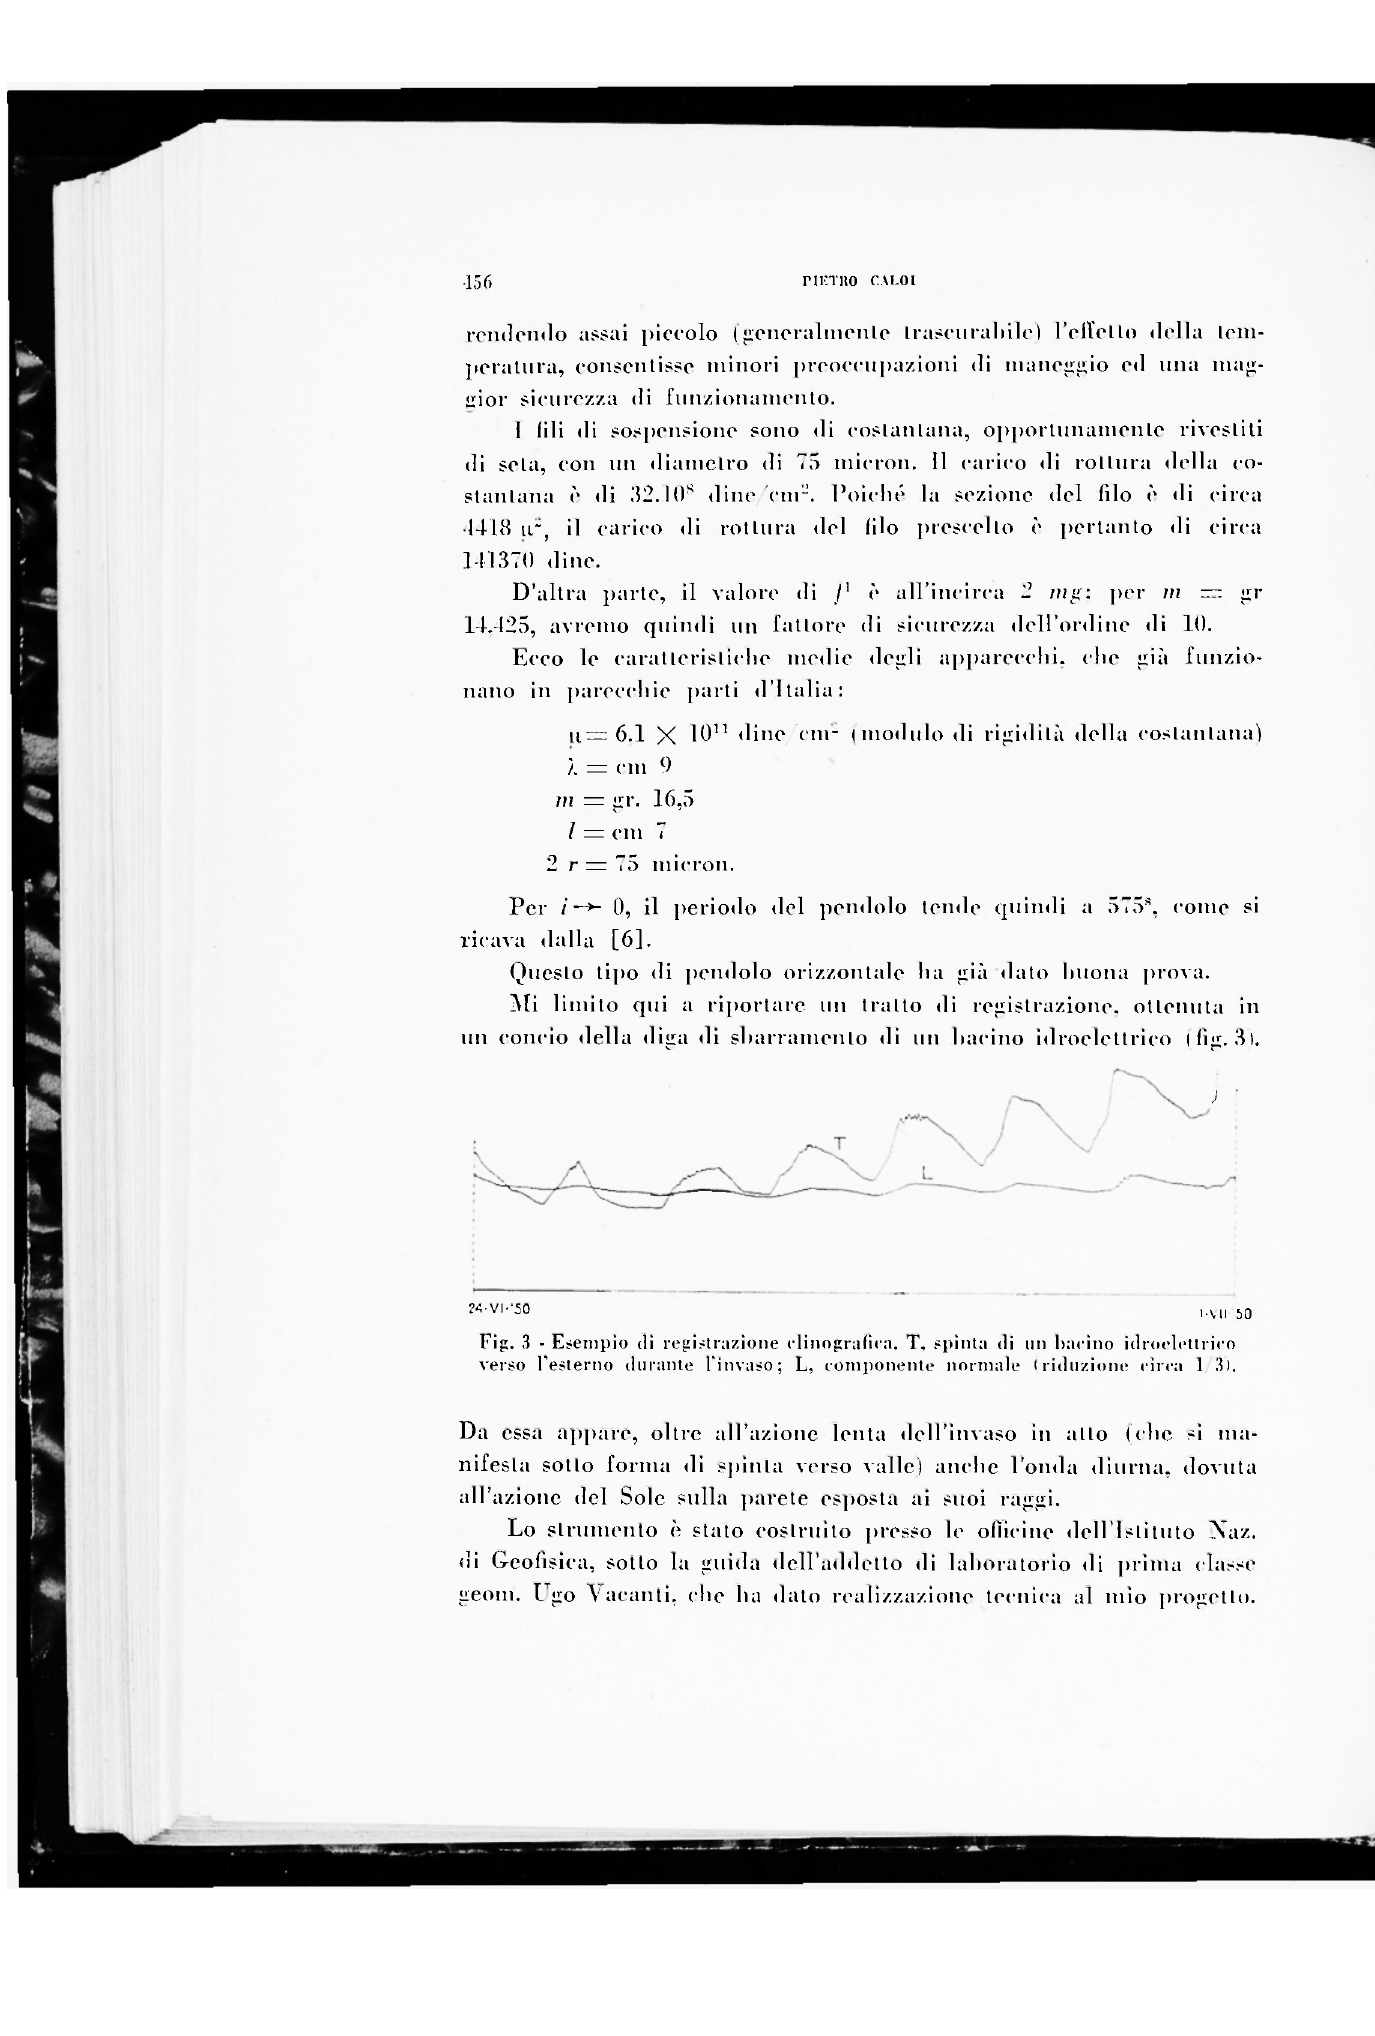
Da essa appare, oltre all'azione lenta dell'invaso in atto (che si ma- nifesta sotto forma di spinta verso valle) anche l'onda diurna, dovuta all'azione del Sole sulla parete esposta ai suoi